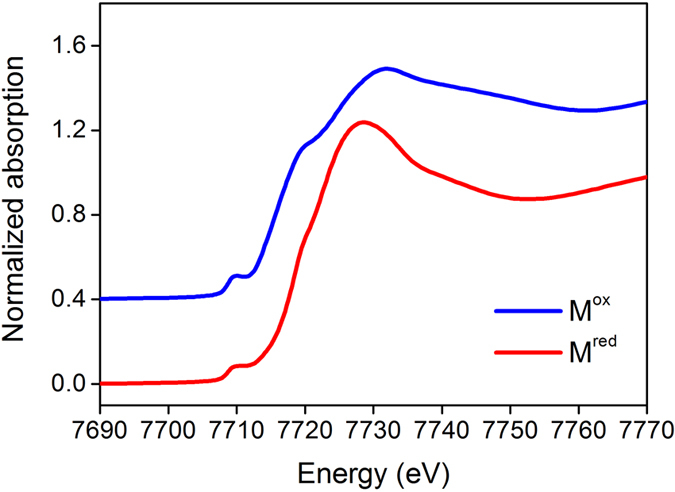
Chemical states of redox mediators.Normalized Co K-edge XANES spectra for Mred and Mox.